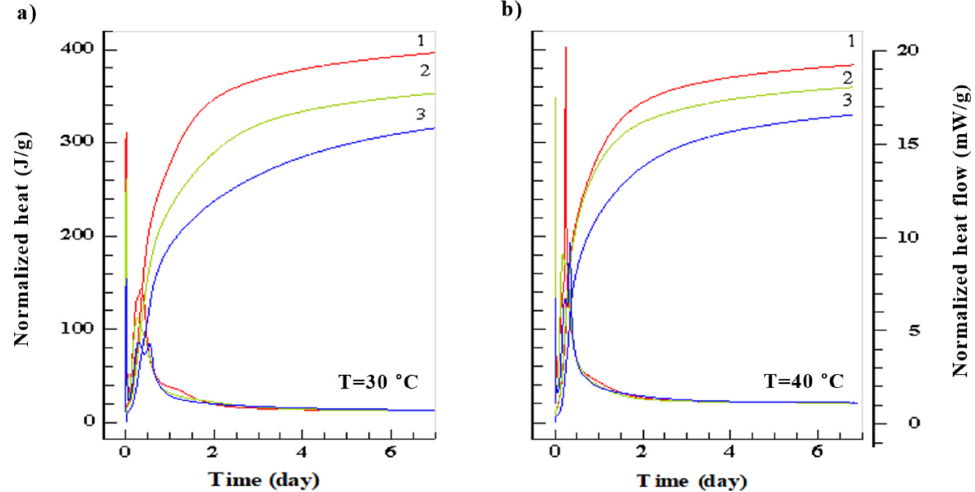
Figure 2. Amount of generated heat (J/g) and flow (mW/g) of studied cements: 1. CEM I 52.5 R, 2. CEM I 42.5 R, 3. CEM III 42.5 N for curing temperatures 30 °C ( a ) 40 °C ( b ).